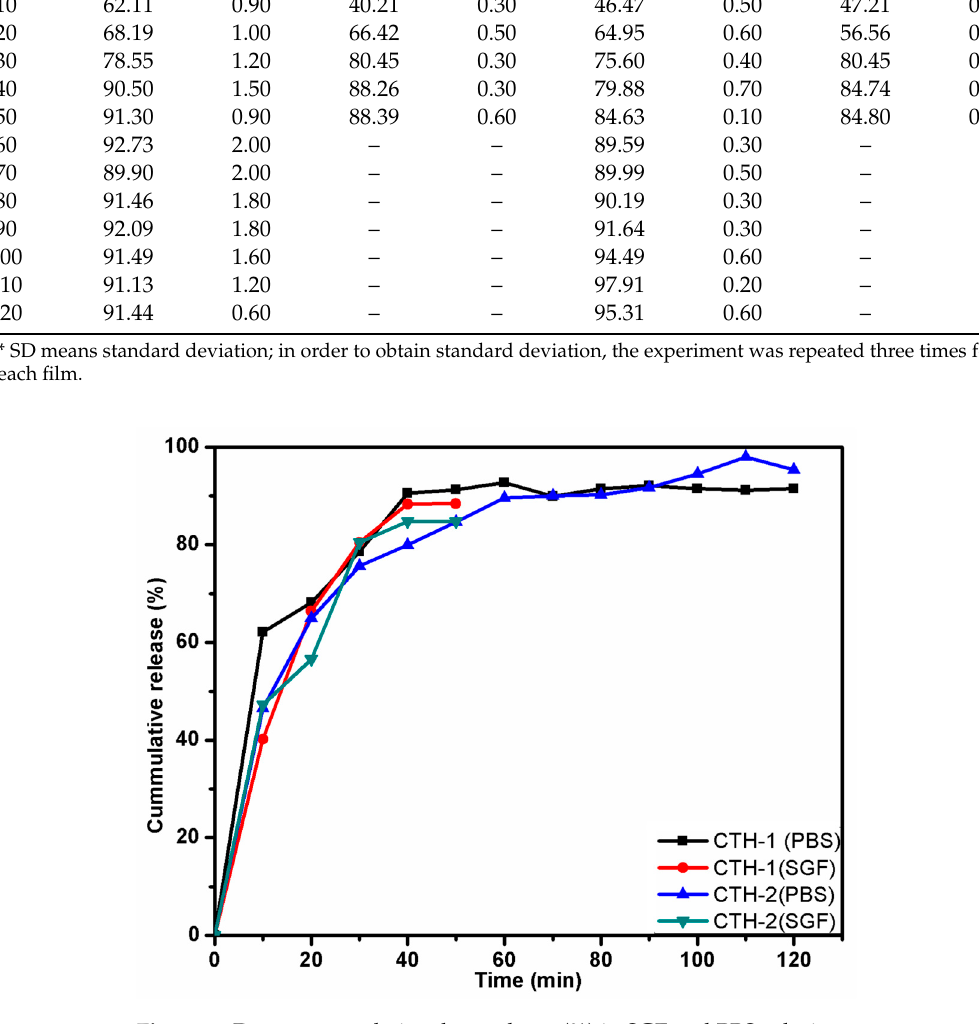
Figure 9. Data on cumulative drug release (%) in SGF and PBS solutions.